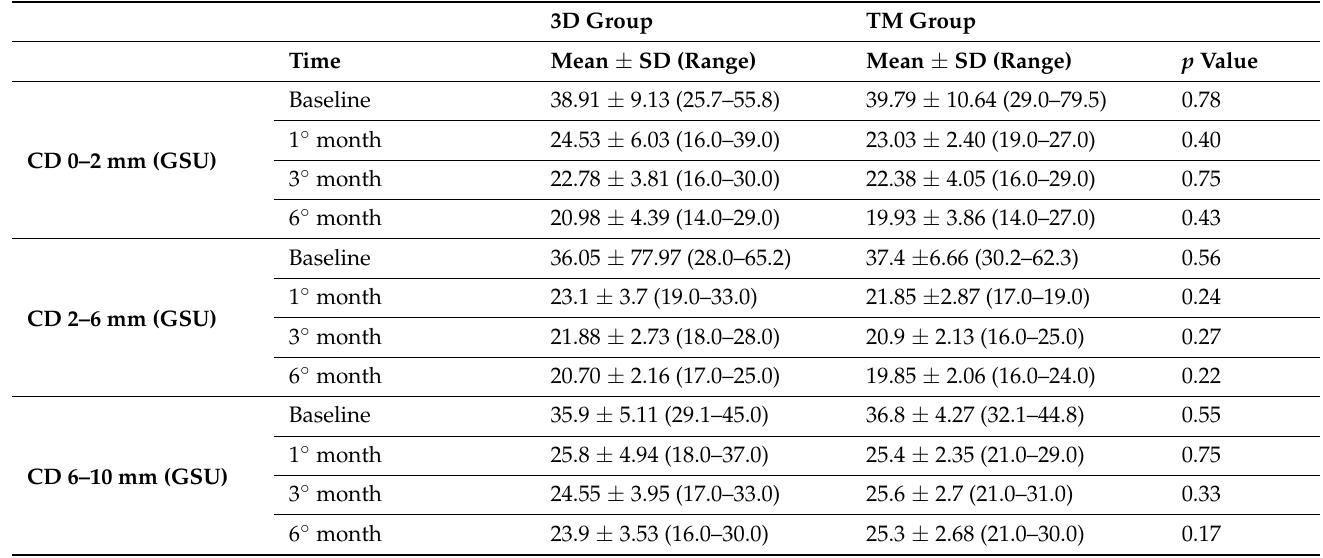
Table 5. Patient preoperative and postoperative corneal densitometry. 3D Group TM